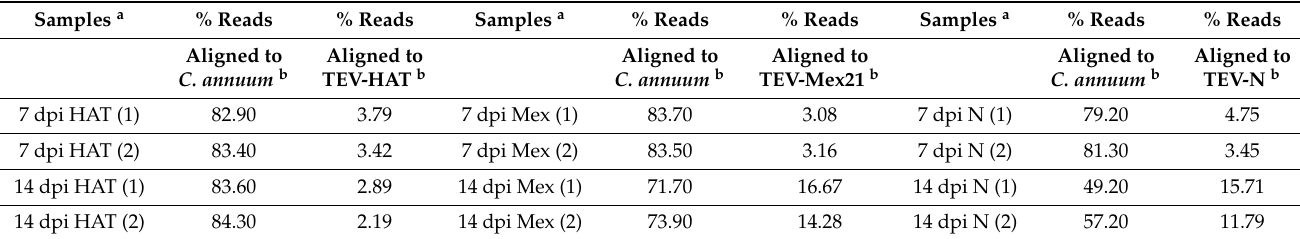
Table 2. Percent reads from RNA-sequencing runs aligned to the Capsicum annuum genome versus the Tobacco etch virus (TEV)